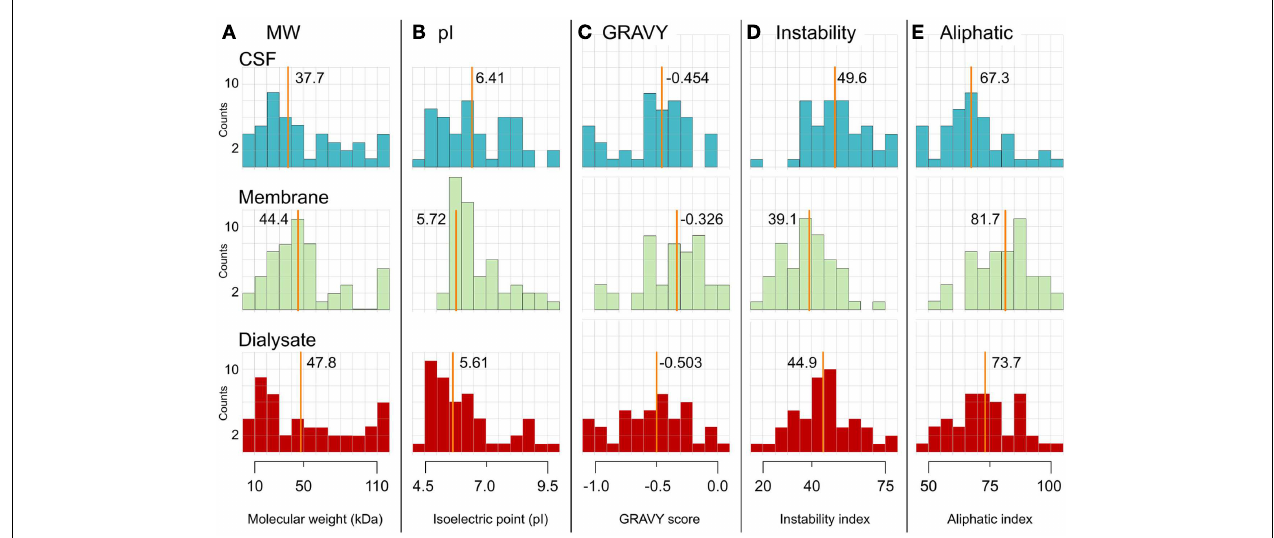
written next to the line, n = 59 for CSF, n = 63 for membrane, and n = 59 for dialyzate.The proteins adsorbed onto the membrane had a significantly lower instability index (i.e., more stable), were more hydrophobic (i.e., higher GRAVY score), and were more thermostable (i.e., higher aliphatic index), compared to the proteins in the CSF and the dialyzate.The results suggest that proteins may escape detection because they are adsorbed onto the MD membranes and thereby prevented from passing the membrane into the dialyzate [(13), Figure S1 in Supplementary Material]. Reprinted with permission fromWetterhall et al. (13). Copyright 2014